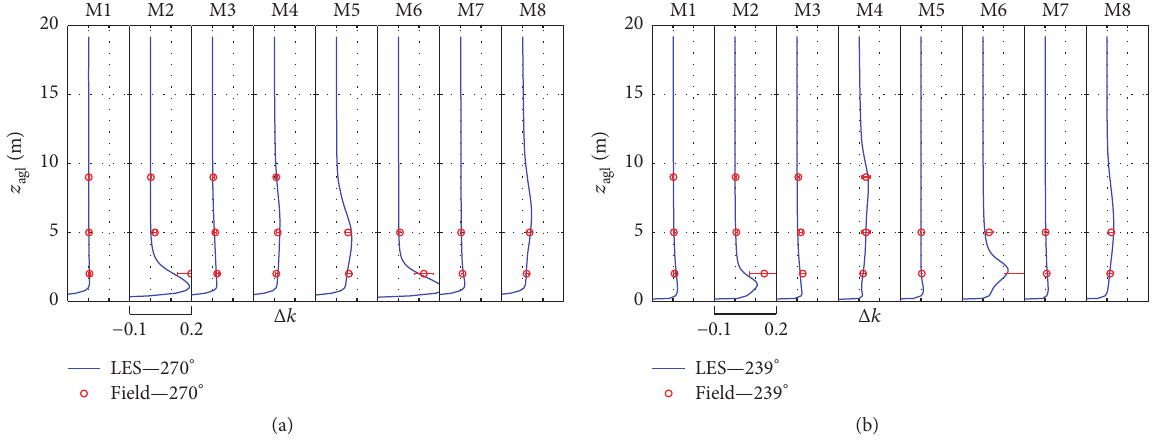
Figure 10: Vertical profiles of the TKE increase ( Δ𝑘 ) at different masts (M1–M8) in the case of 270 ∘ (a) and 239 ∘ (b) wind